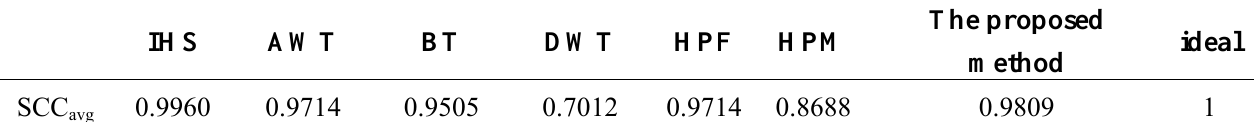
The proposed ideal method